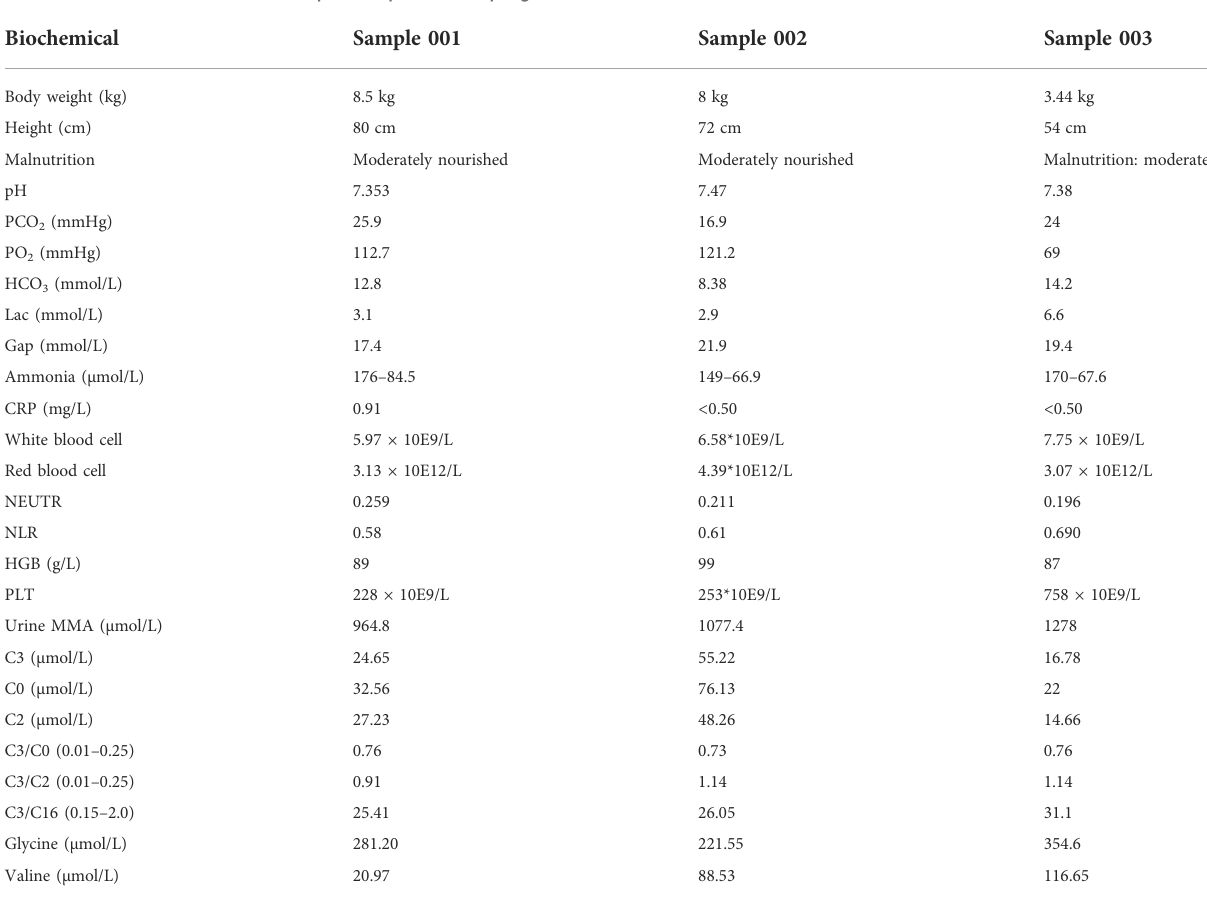
TABLE 2 Clinical information of MMA patients prior to sampling.